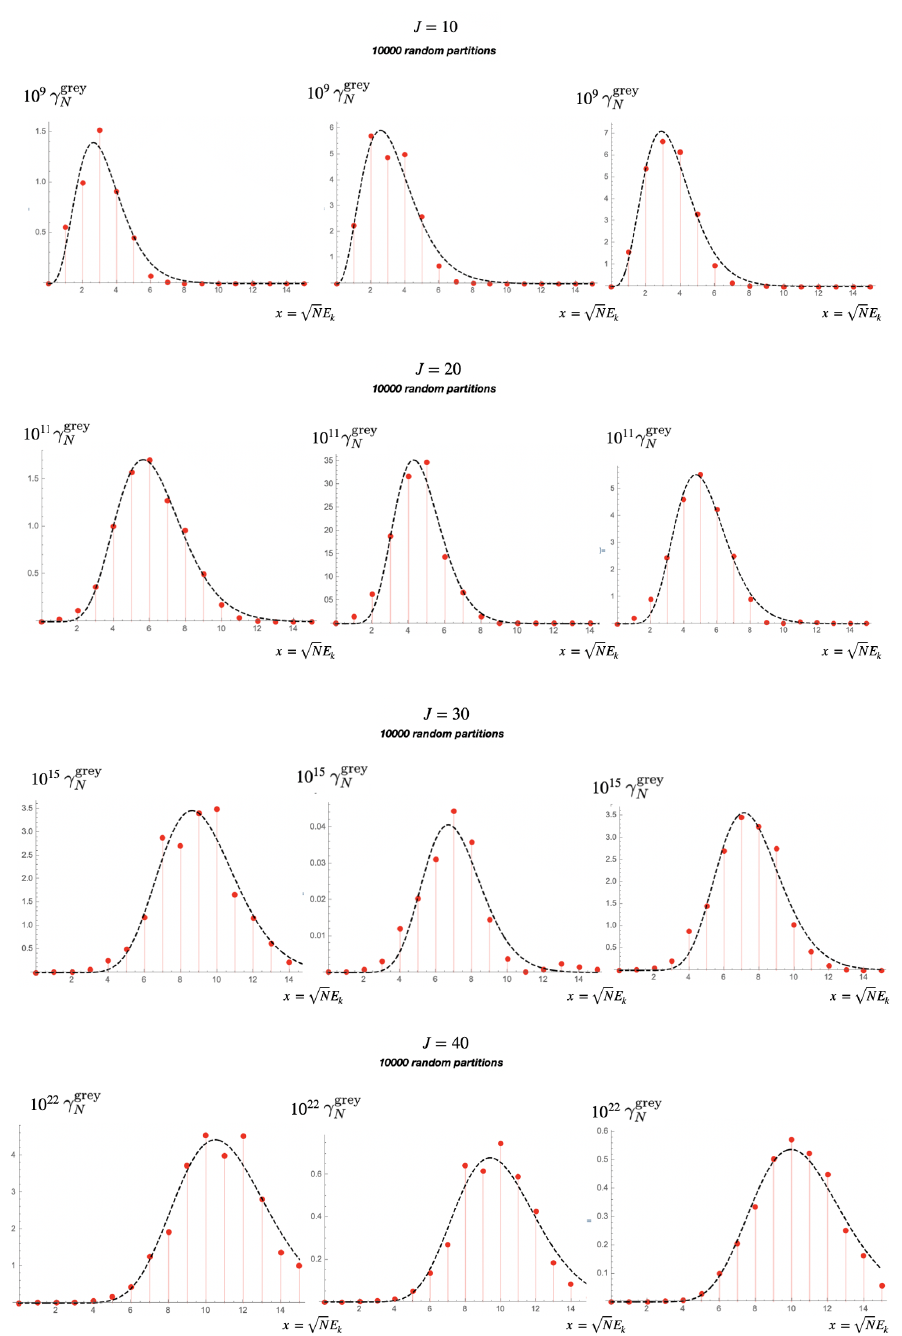
Figure 14 . Some examples of thermal spectra as a function of the occupation number J